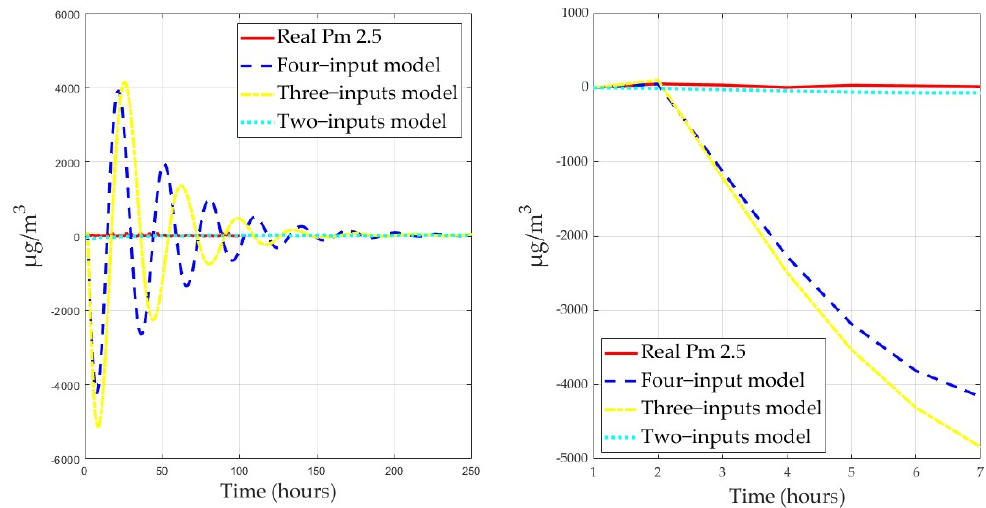
Figure 9. Comparison of the identified models.